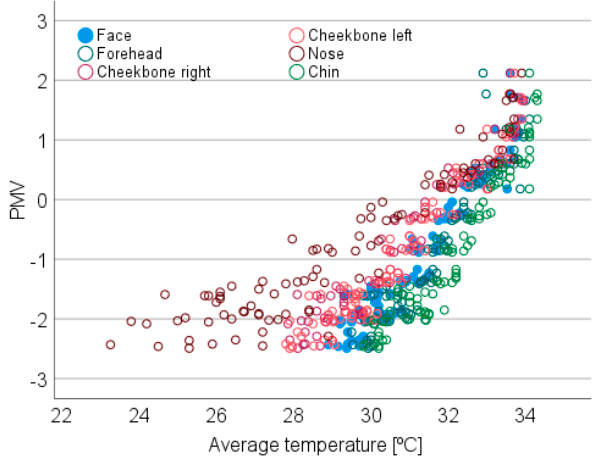
Figure 11. Relations between PMV values and average temperatures for the six regions of the face. Table 3. R 2 and linear tendency lines for the six regions of the face.